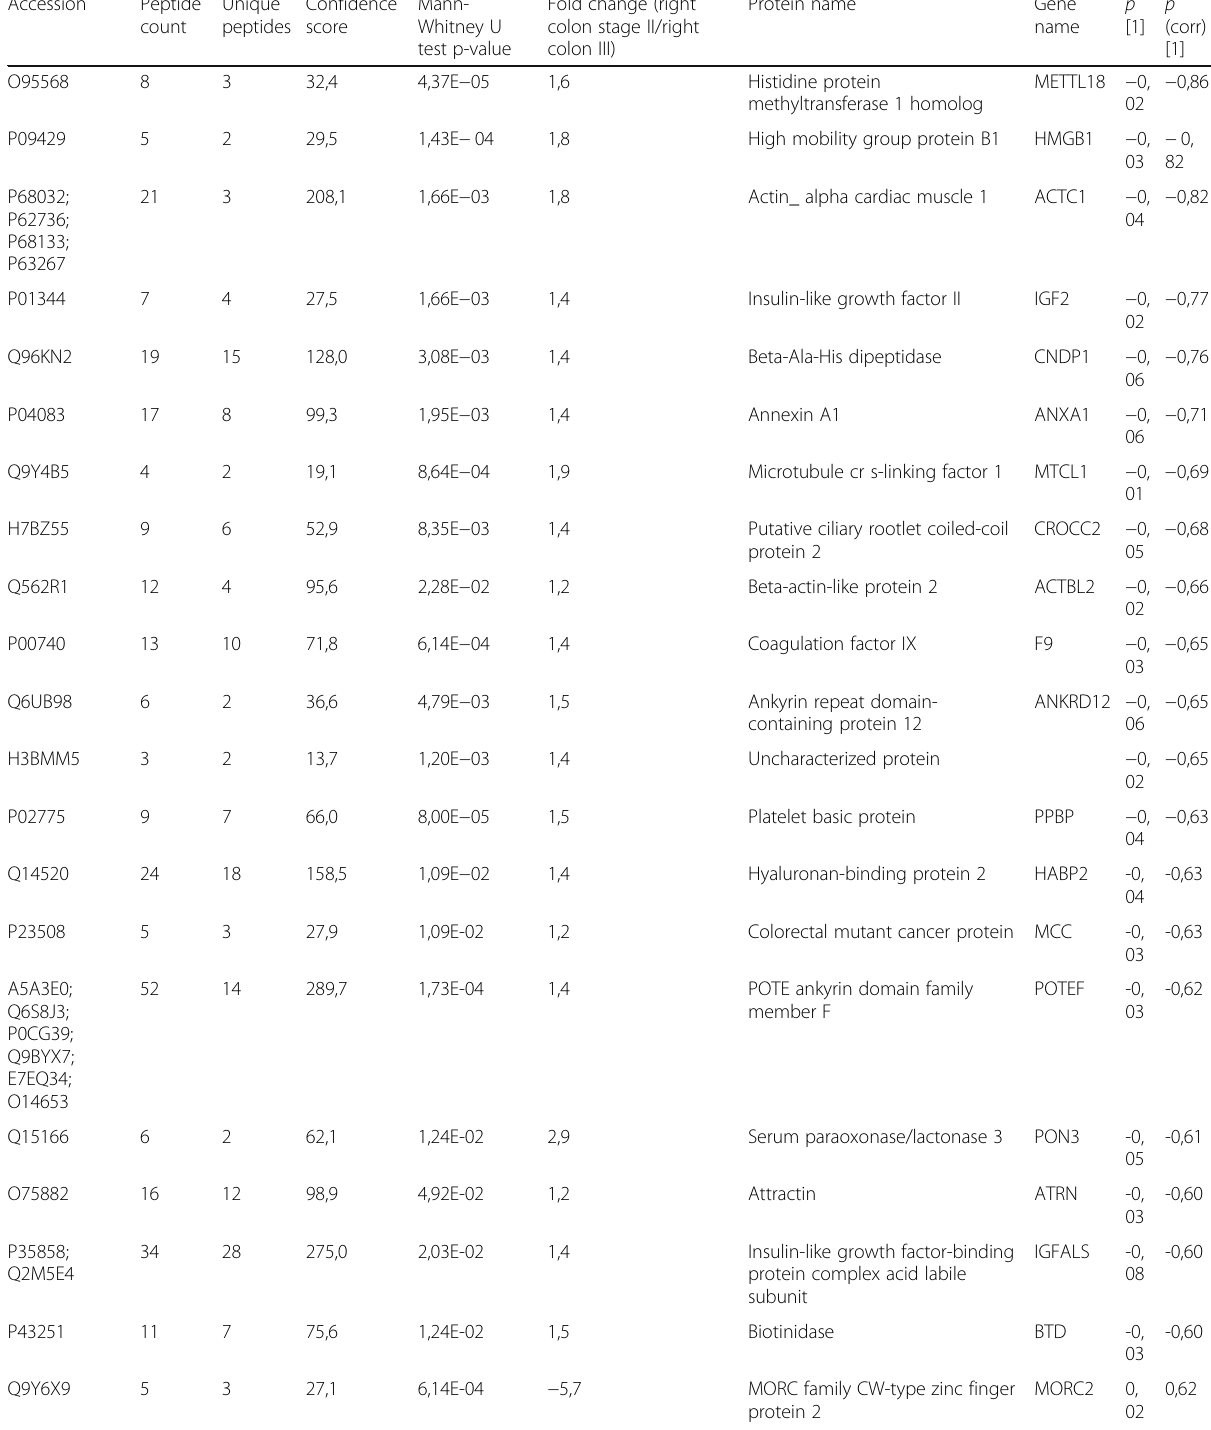
Table 1 The S-plot proteins differing between samples from patients with right-sided stage II and III CRC